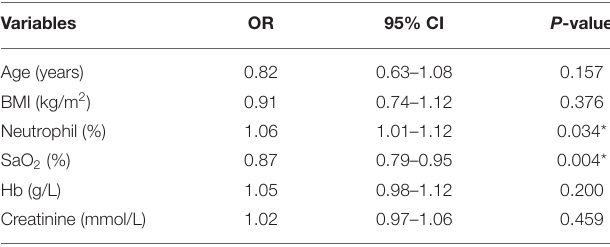
TABLE 6 | Logistic regression analysis of demographic data and biological